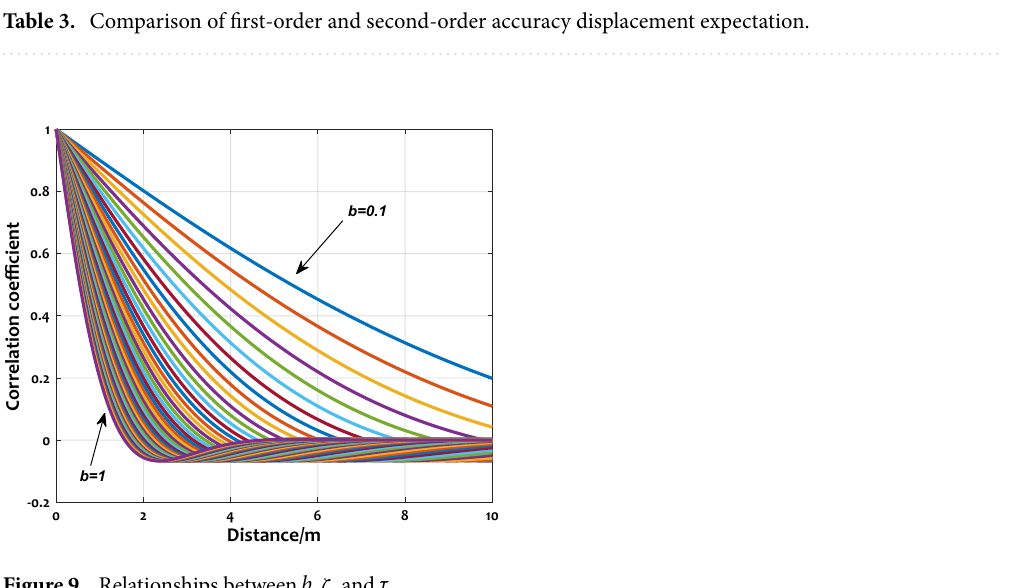
Figure 9. Relationships between b , ζ , and τ